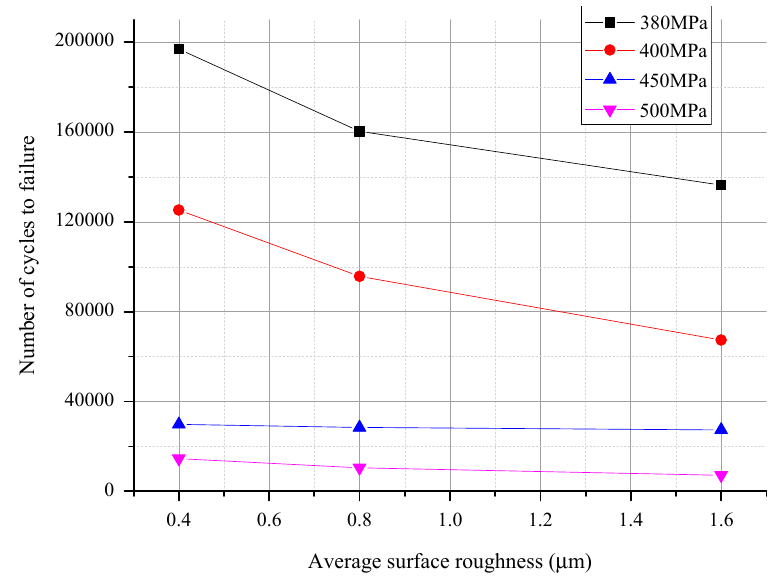
Figure 4. Contrast of mean fatigue life with R a = 0.4 μ m, R a = 0.8 μ m, and R a = 1.6 μ m.